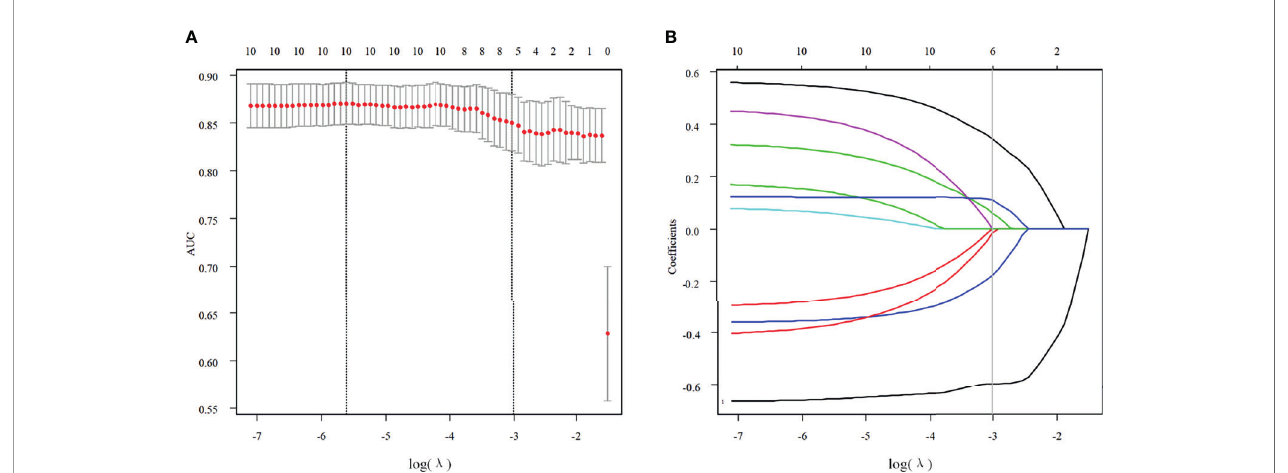
FIGURE 2 | Texture feature selection. (A) Using the LASSO model, tuning parameter ( l ) selection was according to a 5-fold cross-validation. Using the minimum criteria and the 1 standard error of the minimum criteria, dotted vertical lines were drawn for the optimal values. A l value of 0.0495 with a log ( l ) of -3.005783 was chosen for the 5-fold cross-validation. (B) According to the log ( l ) sequence, a coef fi cient pro fi le plot was produced. At the value selected with the 5-fold cross- validation, a vertical line was drawn, where the optimal l resulted in six non-zero coef fi